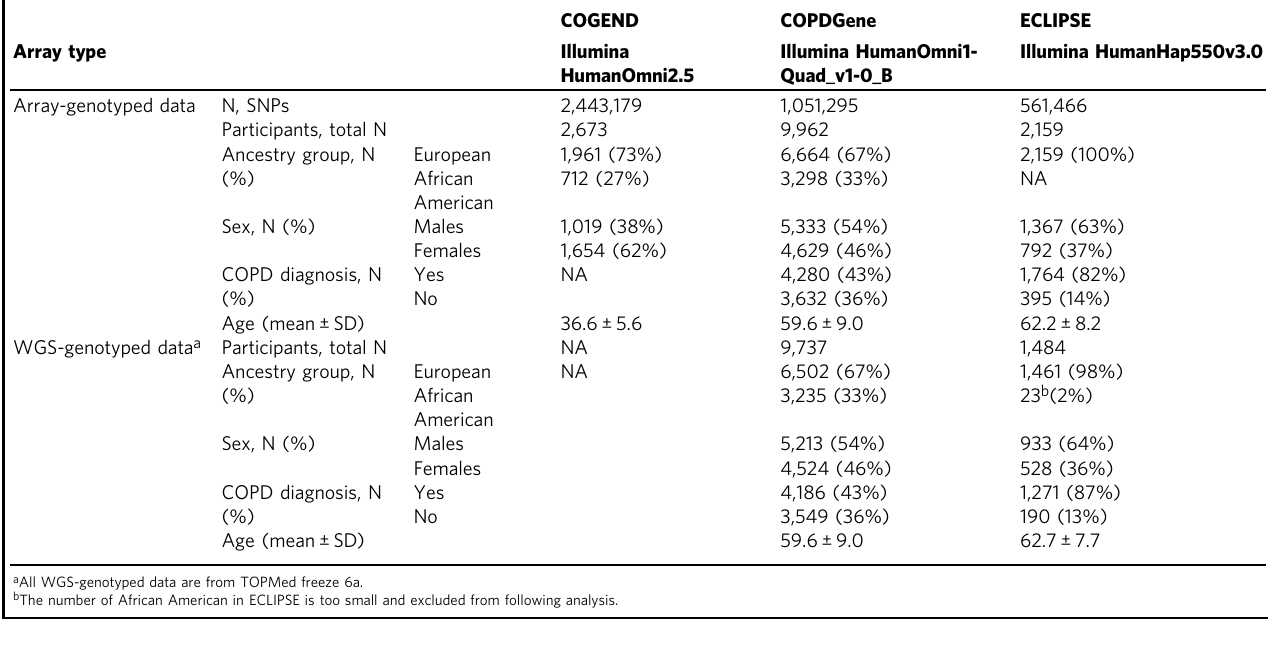
Table 1 Dataset